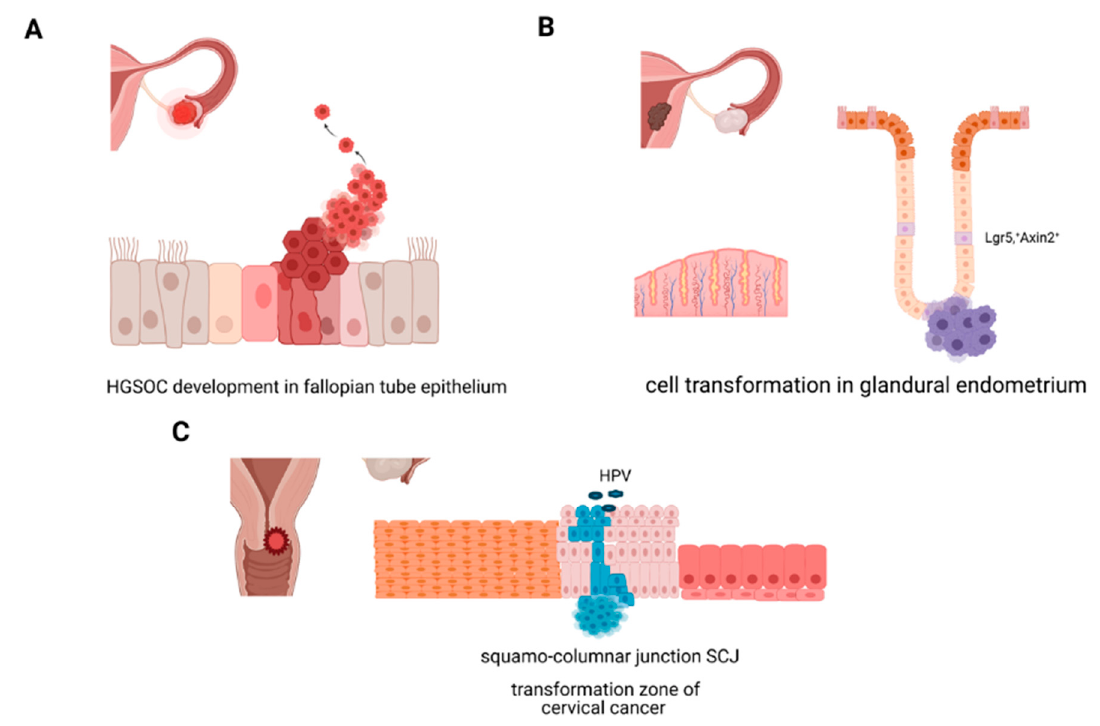
Figure 1. Overview of cell transformation mechanism in ovarian, uterine and cervical cancers. ( A ) HGSOC develops from secretory cells of fallopian tube epithelium. ( B ) Model of endometrial cancer development postulates central role of the stem cells in the uterine glands during the transformation. ( C ) Cervical cancer arises in the transformation zone/squamo- columnar junction of the cervix and is driven by HPV viral infection.